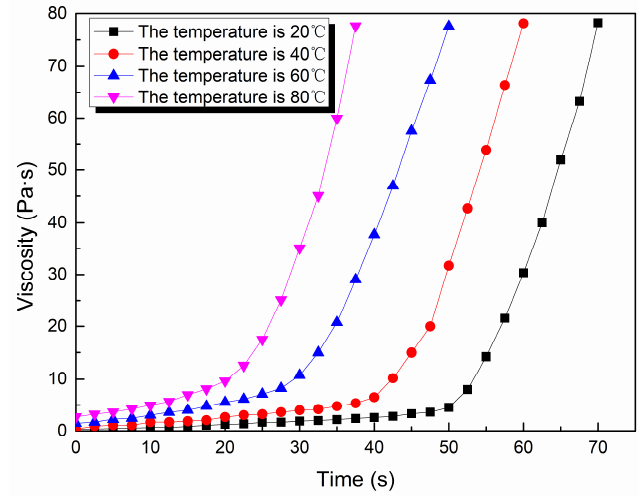
Figure7. Thetime-varyingviscosity curve ofthecement-sodiumsilicateslurry atdi ff erenttemperatures. Materials 2020 , 13 , x FOR PEER REVIEW Figure 7. The time-varying viscosity curve of the cement-sodium silicate slurry at different temperatures.